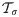
An animal’s movements through a given space are represented in the coactivity complex.A: Two topologically equivalent paths in a physical environment, γ1 and γ2 (this commonly used notation for the paths is unrelated to γ-rhythm), encircle an obstacle (white square) and are therefore non-contractible. The path γ3 does not encircle the obstacle and therefore is contractible and topologically inequivalent to γ1 and γ2. B: A schematic representation of the 2D skeleton of the coactivity complex Tσ (vertices shown as black dots, the 1D links as white lines and 2D facets as grey triangles) and of the simplicial paths Γ1, Γ2 and Γ3, which represent the physical paths γ1, γ2 and γ3. The topological equivalences and inequivalences between the simplicial paths (Γ1 ≅ Γ2 and Γ1 ≇ Γ3, Γ2 ≇ Γ3) provide qualitative information about the physical paths, encoded via place cell coactivity. Since we are concerned primarily with representing the topological properties of the navigational paths, in the following we discuss only the 2D skeleton of the coactivity complex. C: Timelines of the topological loops encoded in the coactivity complex. As the animal begins to explore its environment, the coactivity complex contains many spurious topological loops (gaps in the information about that part of the environment) most of which do not represent the physical obstacle. This “topological noise” in the depicted graph disappears after about five minutes, which marks the learning time, Tmin—the moment when the correct topology of space has emerged. One 1D loop represents the obstacle and one 0D loop informs us that the environment is connected.